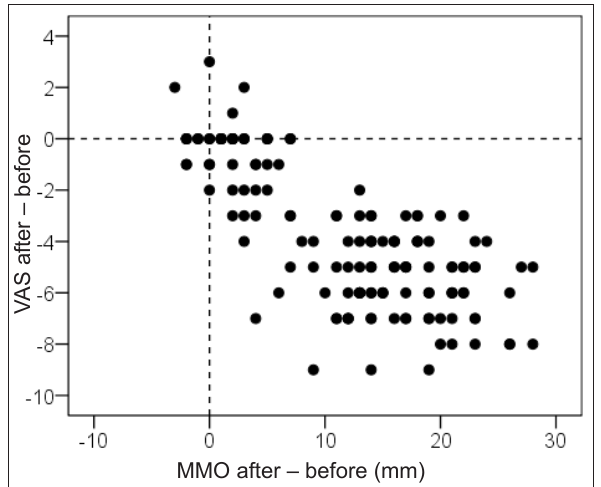
Fig. 4. Point scatter plot, change in MMO vs. change in